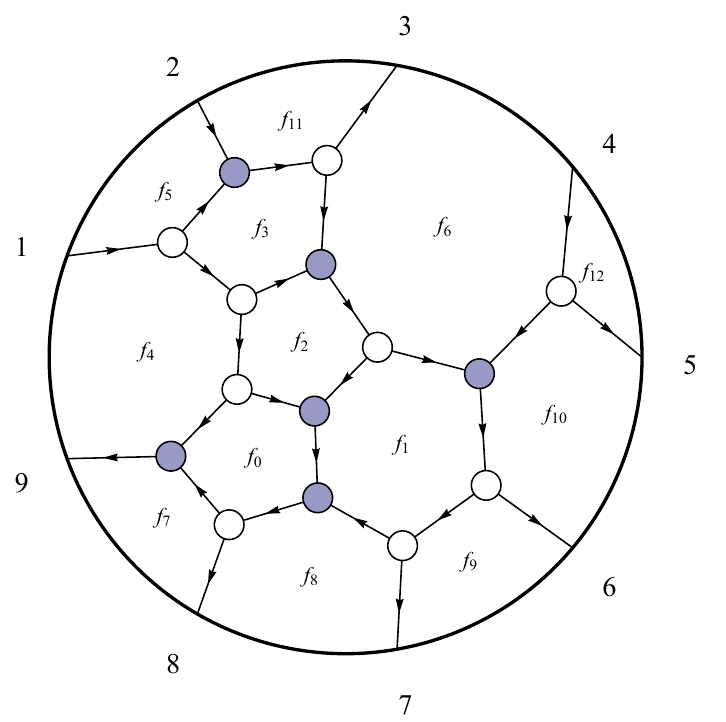
Figure 3 . Plabic graph associated to the decorated permutation { 3 , 6 , 8 , 5 , 9 , 7 , 11 , 10 , 13 } in G (3 , 9) +